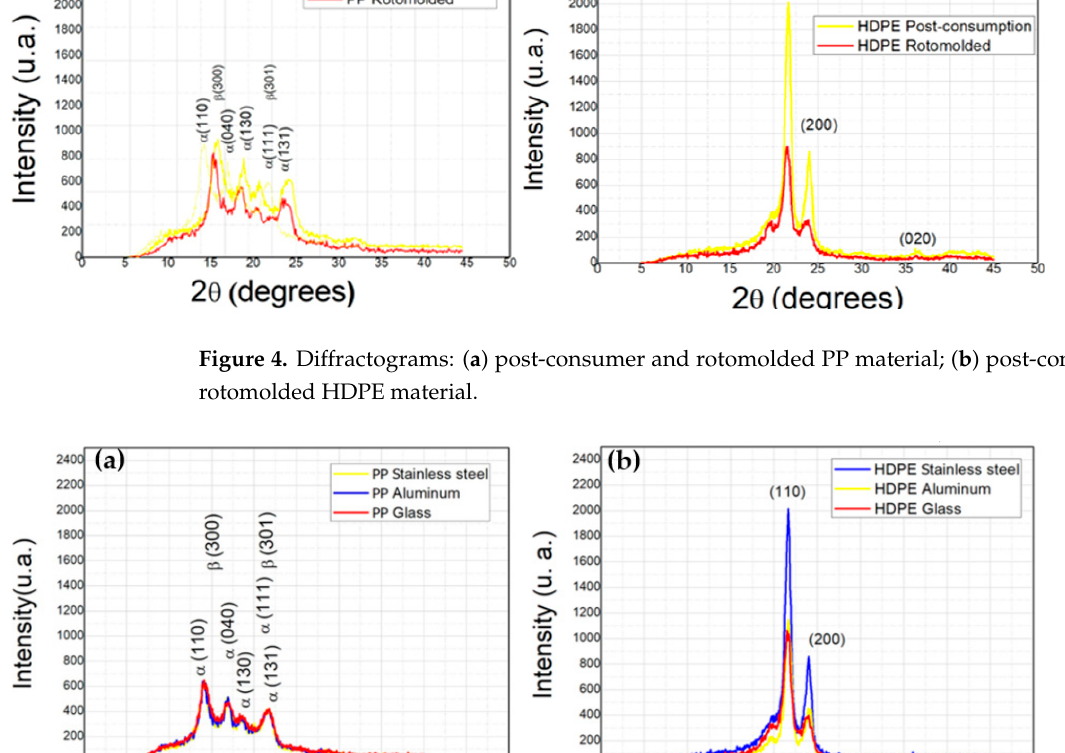
Table 1. Flexural Results.